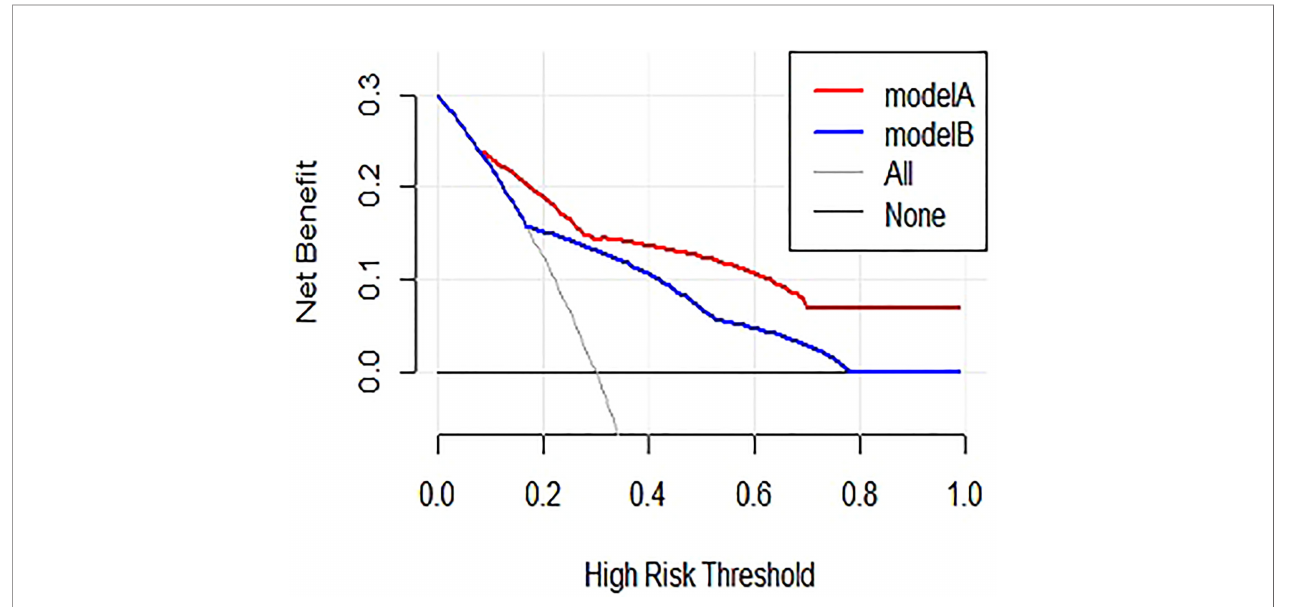
FIGURE 3 | Results of decision curve analysis. Model A = combined model, model B = image-only model. Net bene fi t in relation to threshold probability for